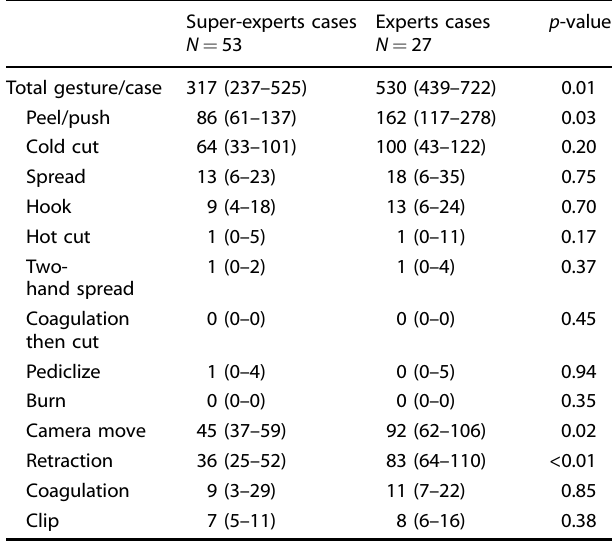
Table 3. Gesture number comparison between super-experts and experts in nerve